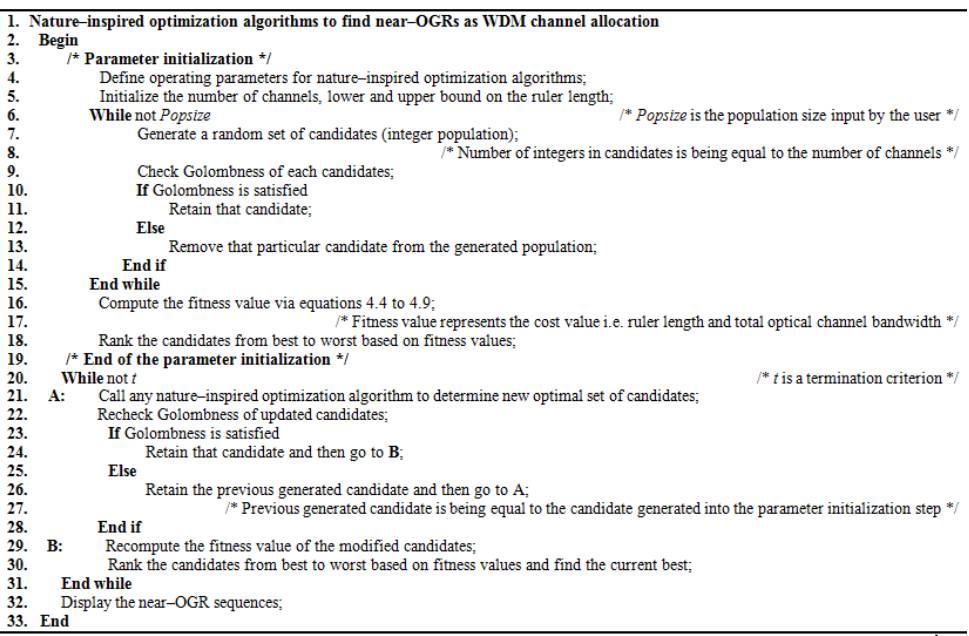
Figure 6: The general pseudo–code to find near–OGRs as WDM channel allocation by using nature–inspired optimization algo- rithms